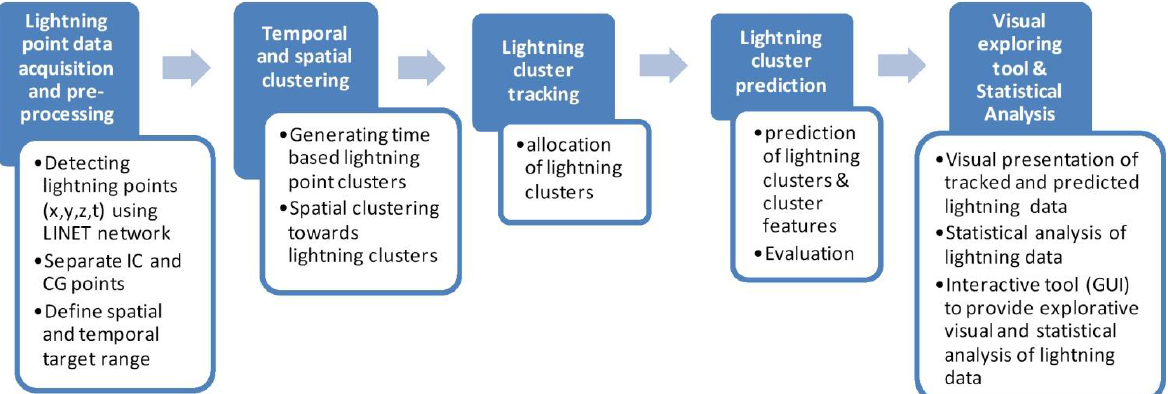
Figure 2. Overall workflow: from data detection to visual analysis.